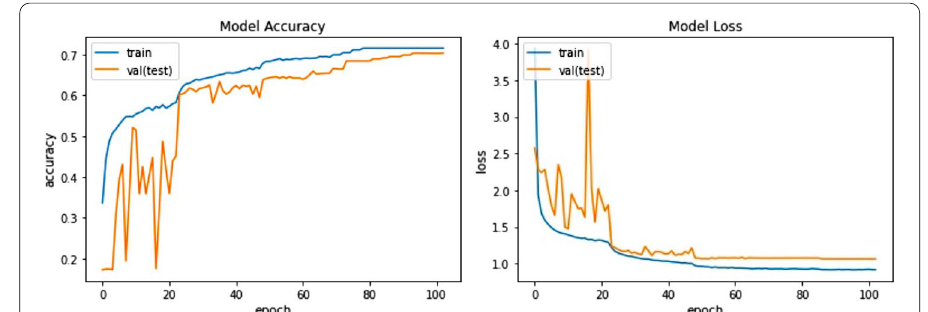
Fig. 6 Training and testing accuracy and loss of ARCH-1 with FER2013 dataset